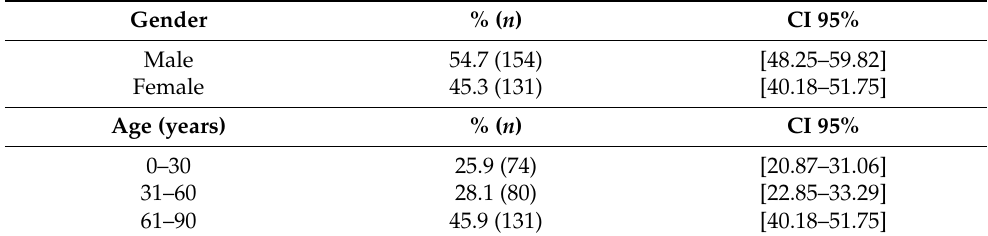
Table 2. Ocular infection distribution among patients according to gender and